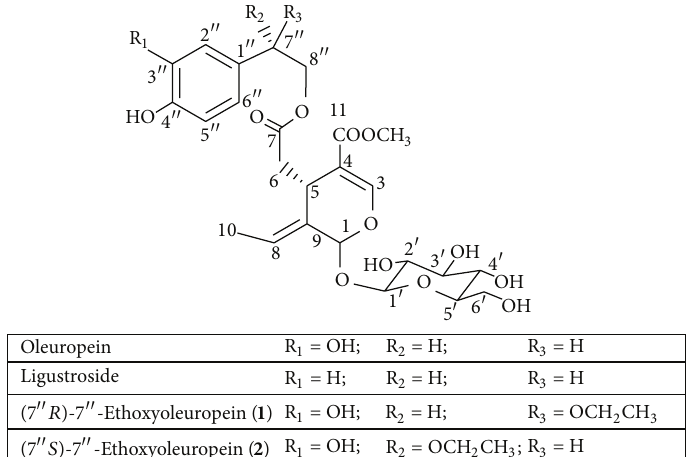
Figure 9: Structures of the isolated compounds from the olive wood sample D .